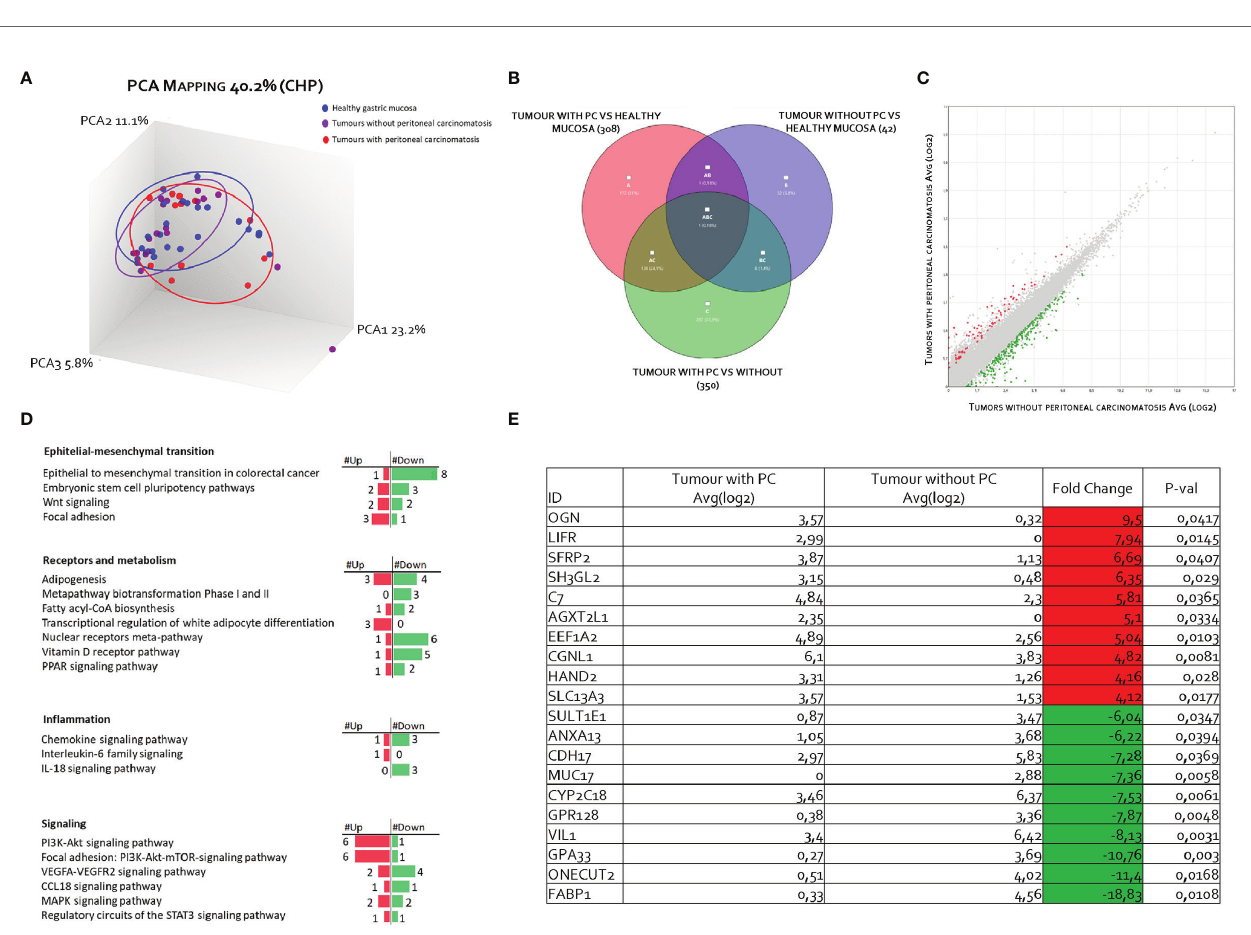
FIGURE 2 | Transcriptome analysis of gastric cancer and paired normal tissues in 31 patients with advanced gastric cancer. (A) Heterogeneity characterization of gastric samples showed by principal component analysis (PCA) plot. (B) Venn diagram of differentially expressed genes showing the overlapping regions between the three comparison groups: gastric cancer with peritoneal carcinomatosis vs. healthy mucosa (red subset), gastric cancer without peritoneal carcinomatosis vs. healthy mucosa (blue subset), and gastric cancer with peritoneal carcinomatosis vs. gastric cancer without peritoneal carcinomatosis (green subset). (C) Scatter plots of transcripts differentially expressed between gastric cancer tissues with peritoneal carcinomatosis and gastric cancer tissues without peritoneal carcinomatosis. (D) For pathways analysis of green subset, identi fi cation of pathways can be grouped in four clusters: epithelial – mesenchymal transition, receptors and metabolism, in fl ammation, and signaling. (E) Table showing the fold change of expression of the top 10 upregulated and downregulated genes included in green subset (fold change of < − 2 or >+2 and p-value of <